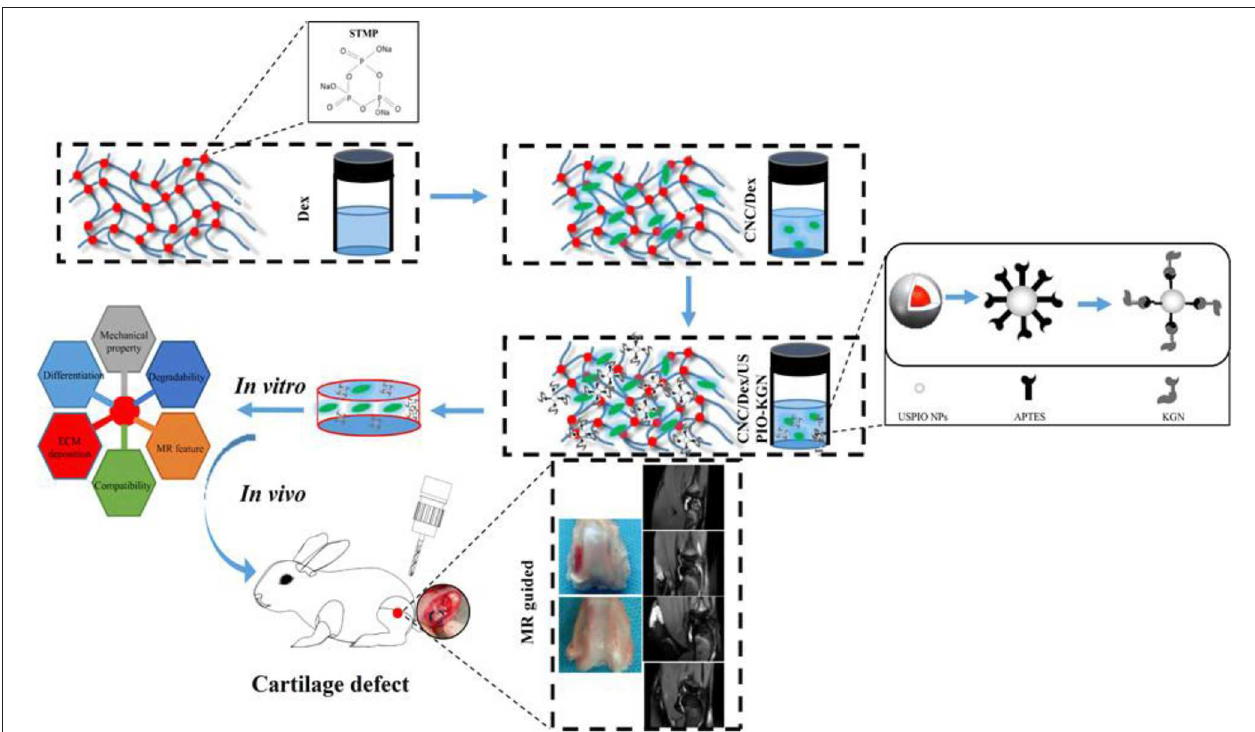
FIGURE 8 | Schematic illustration of preparation and utilization of USPIO-labeled Dex/CNC/USPIO-KGN hydrogels for artificial cartilage repair. Reproduced from Yang et al. (2019) with permission from Copyright 2019 American Chemical Society.